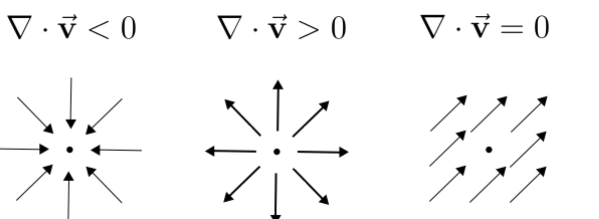
Figure 4. Divergence of different vector fields , ∇ · v = ∂ x v x + ∂ y v y . From left to right: contraction (“sink”, leading to event collapse), expansion (“source”), and incompressible fields. Image adapted from khanacademy.org (accessed on 6 July